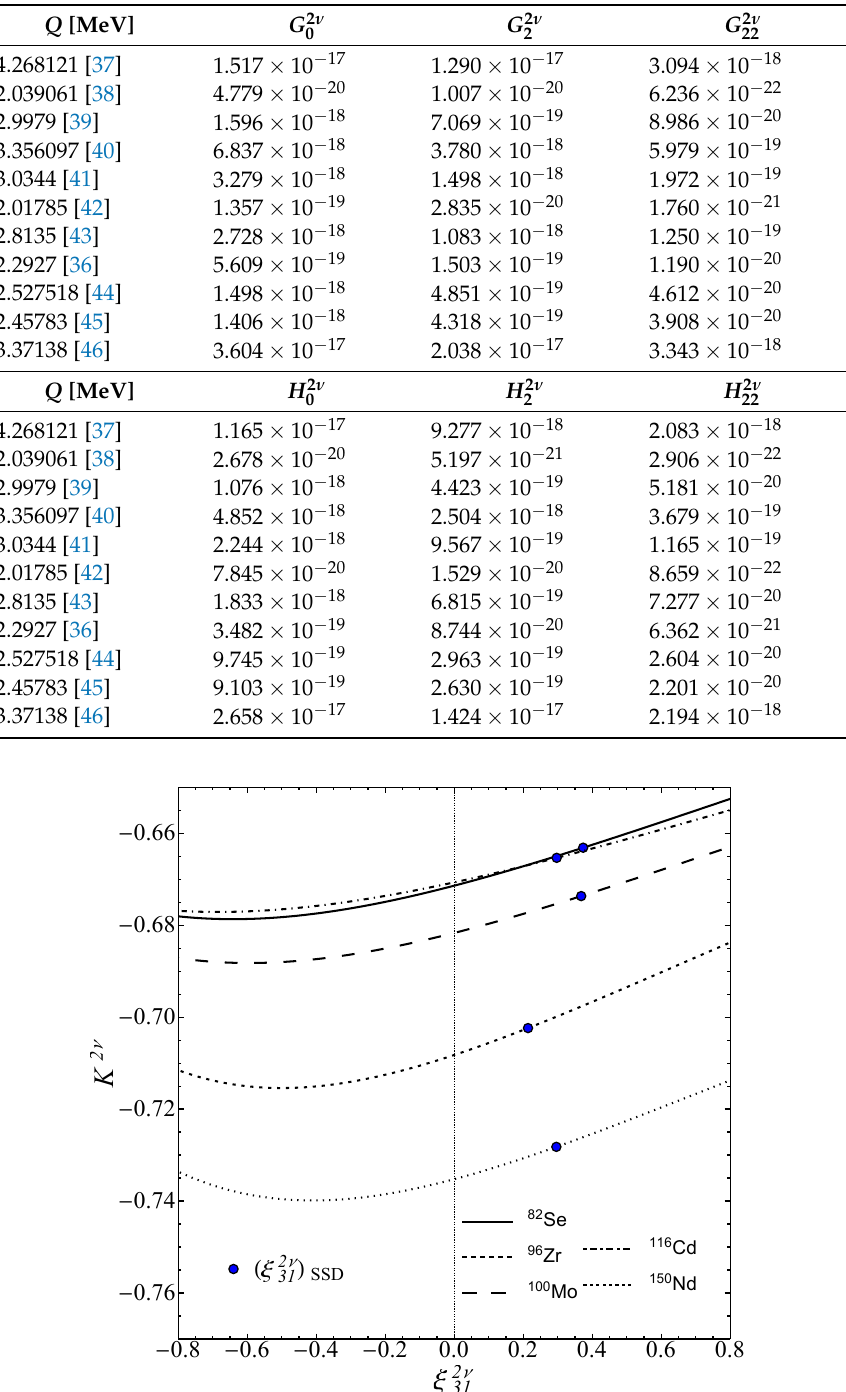
. The filled blue circles indicate the values of K 2 ν 31 (cid:0) (cid:1) ξ 2 ν . In the case of 31 SSD